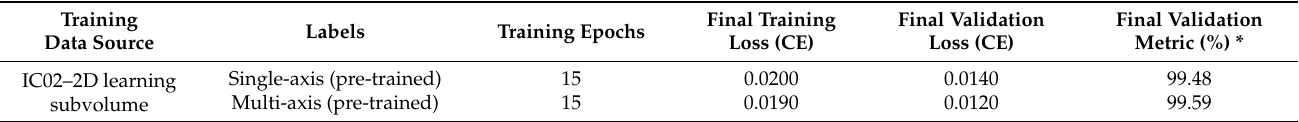
Figure 8. Segmentation time required using an Nvidia Tesla V100 ® GPU for the U-Net methods and HPCC of 40×Intel Gold 6242R ® CPU @ 3.10 GHz for the standard methods. Benchmarking data were